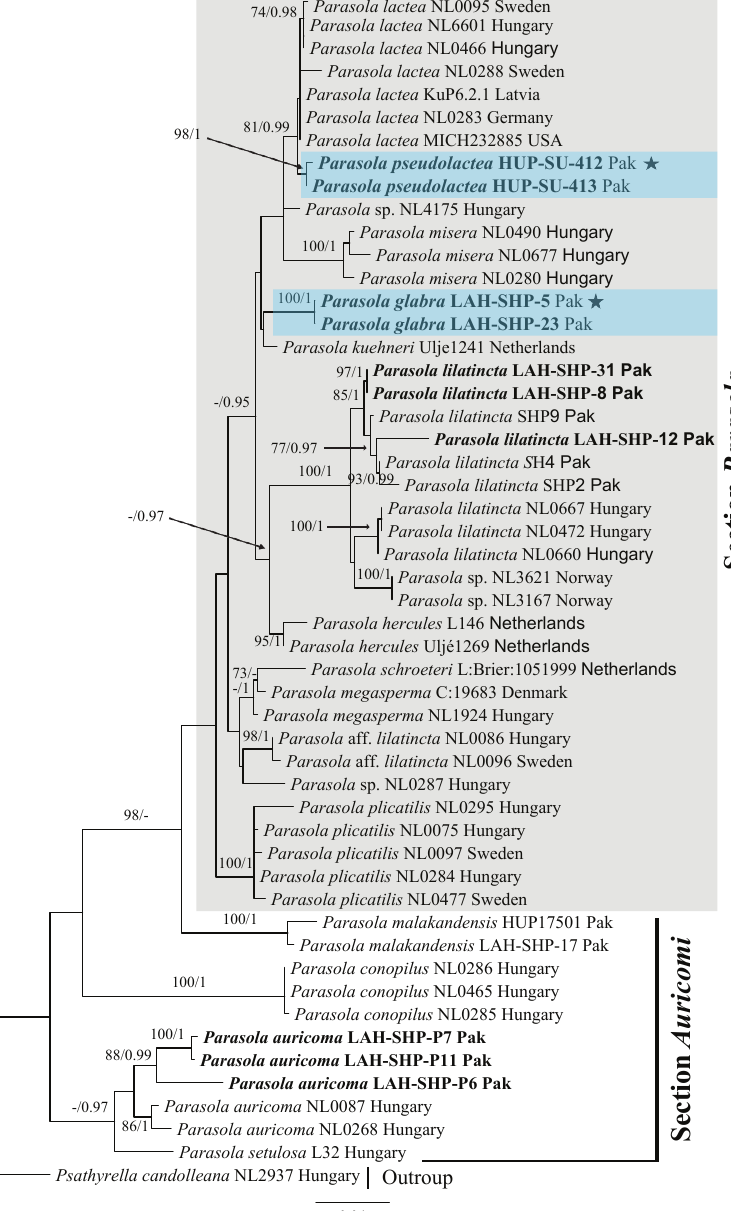
Figure 1. Phylogeny of Parasola species based on 52 ITS sequences. Our sequences are indicated in bold- face. Other sequences are from Nagy et al. (2009). Numbers above or below branches indicate maximum likelihood bootstrap percentages followed by Bayesian posterior probabilities. Species in section Parasola are gray highlighted where the new species are shown as light-blue highlighted, while the HOLOTYPE collection for P. glabra (LAH-SHP-5) and P. pseudolactea (HUP-SU-412) are represented by stars